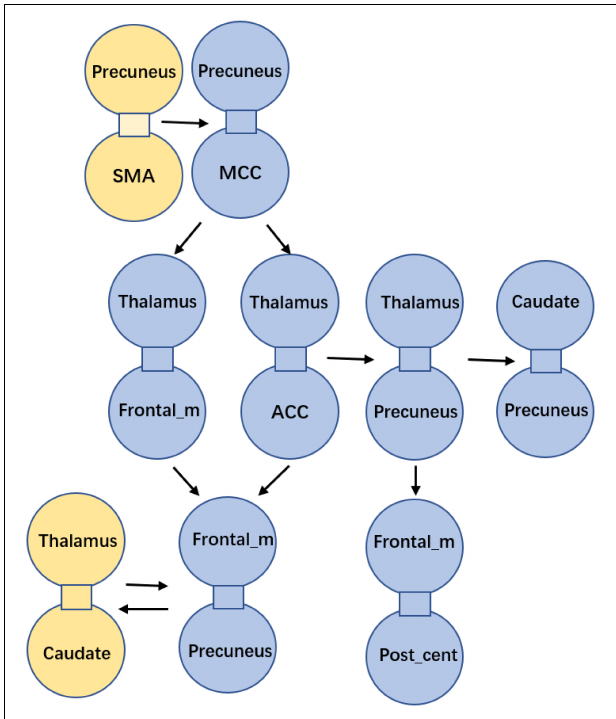
FIGURE 4 | Causality among the abnormal FNCs in IGE. Each bounded sub-graph in the figure is one abnormal connection in IGE, with the yellow sub-graph denoting the increased connection, and the blue sub-graph denoting the decreased connection in IGE. The arrows denoted the predictive directions among the connections.